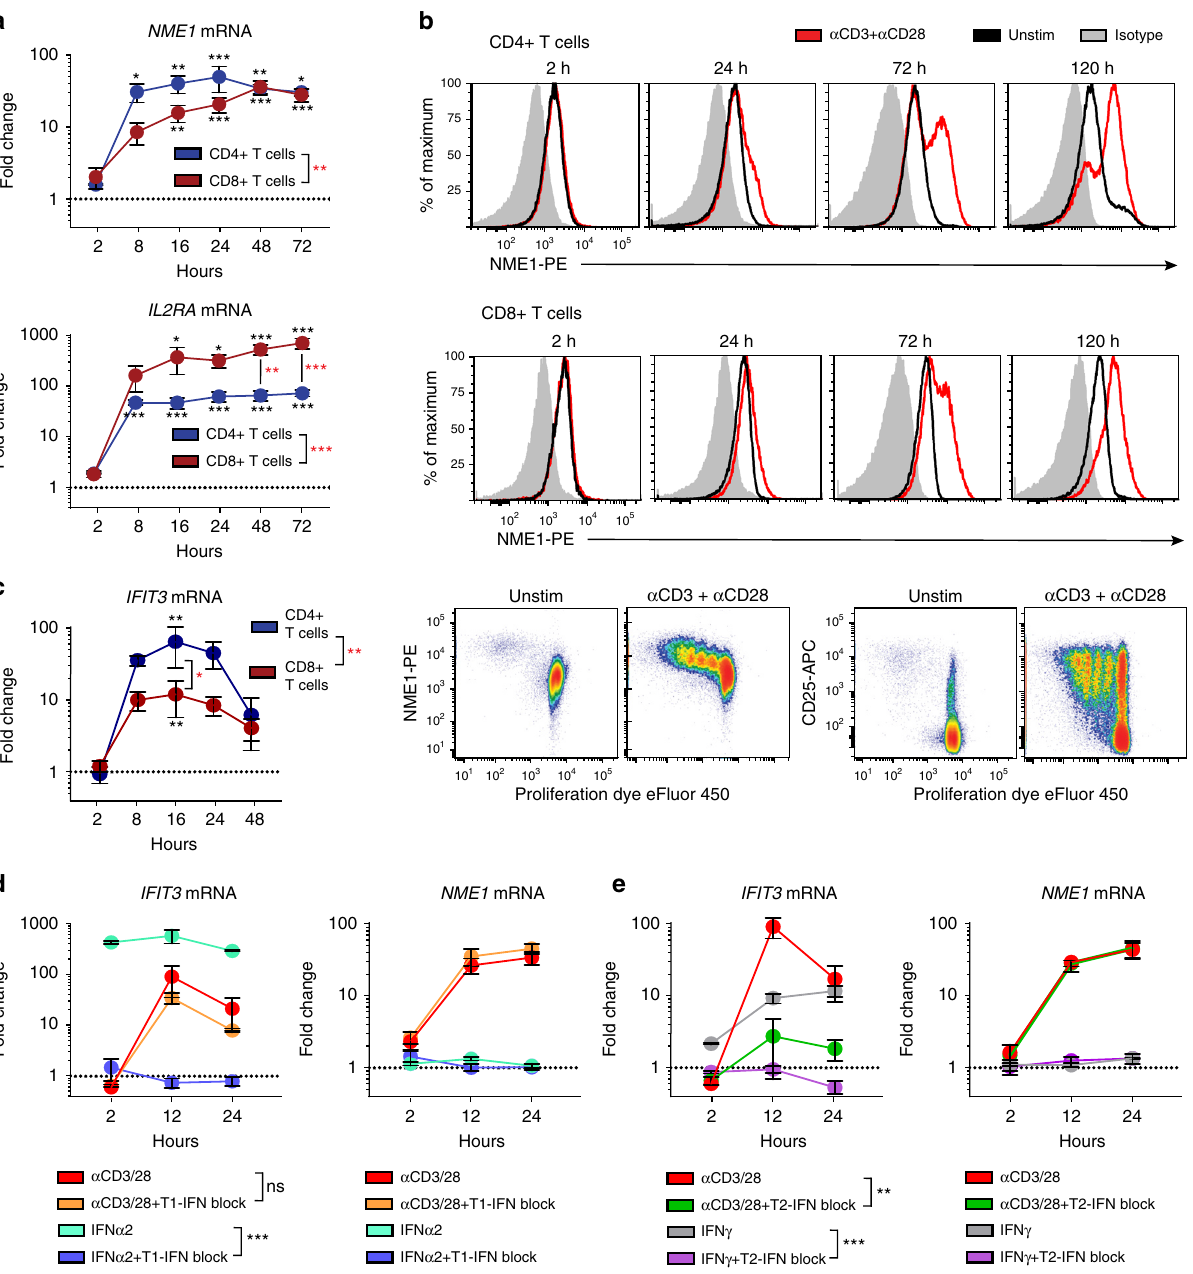
Fig. 5 Induction of NME1 and IFIT3 expression during T cell activation. a Expression of NME1 and IL2RA mRNA by blood CD4 + or CD8 + T cells after stimulation with anti-CD3/anti-CD28 antibodies by qPCR. Data shown as mean fold-change (±SEM) relative to unstimulated CD4 + or CD8 + T cell controls (dotted line) from 4 individuals (independent experiments). Statistical analysis between stimulated and unstimulated cells (black asterisk) or CD4 + and CD8 + T cells (red asterisk) made by two-way ANOVA with Sidak test for multiple comparisons. b Intracellular NME1 protein expression by blood T cells after stimulation for indicated timepoints (red) compared to unstimulated (black) and isotype control (gray). Bottom row: CD25 and NME1 expression by proliferating CD3 + T cells after 5 days of stimulation. Data are representative of 4 individuals. c Expression of IFIT3 mRNA in blood T cells by qPCR after TCR-stimulation, shown as mean fold-change (±SEM) relative to unstimulated controls (dotted line) for four individuals. Two-way ANOVA with Sidak test for multiple comparisons was used for statistical comparisons (black asterisk, stimulated versus unstimulated) or (red asterisk, CD4 + versus CD8 + T cells). d IFIT3 or NME1 mRNA expression in CD4 + T cells after culture with anti-CD3/anti-CD28 or IFN α 2 (1000 units/mL) ± type I IFN neutralizing antibody cocktail or e IFN γ (10 ng/mL) ± anti-IFN γ /anti-IFN γ R1 antibodies (1 µ g/mL each), shown as mean fold-change (±SEM) relative to unstimulated controls (dotted line) for three individuals. Statistical comparisons made by two-way ANOVA. For all panels: “ ns ” denotes not signi fi cant; * p ≤ 0.05; ** p ≤ 0.01; *** p ≤ 0.001. Source data for gene expression values are provided in the Source Data fi